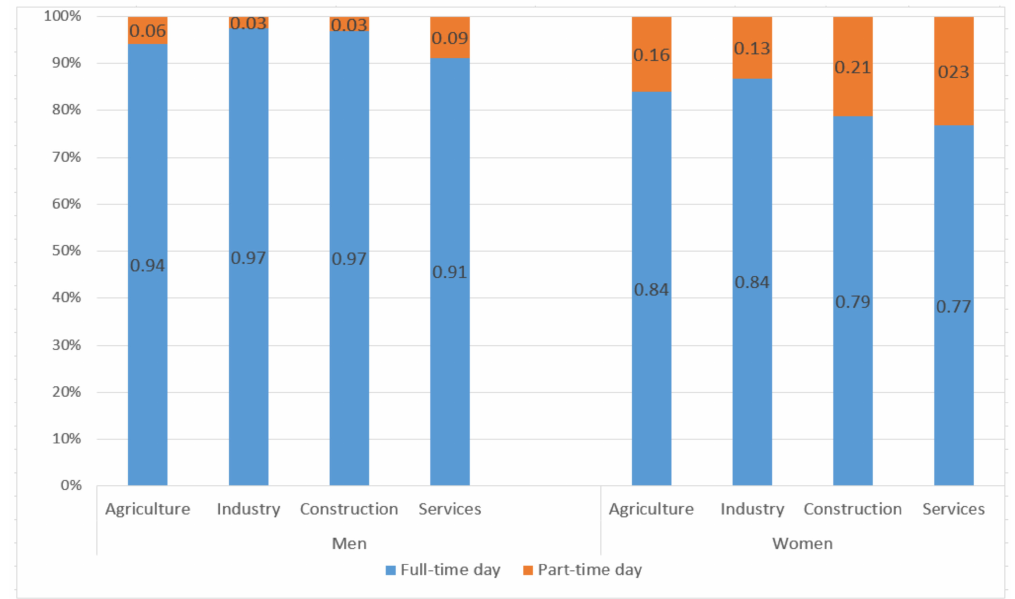
Figure 4. Working day by sex and activity sectors, in percentage (third quarter of 2020). Source: Own elaboration from data of the Spanish National Statistics Institute (INE, (data free use))